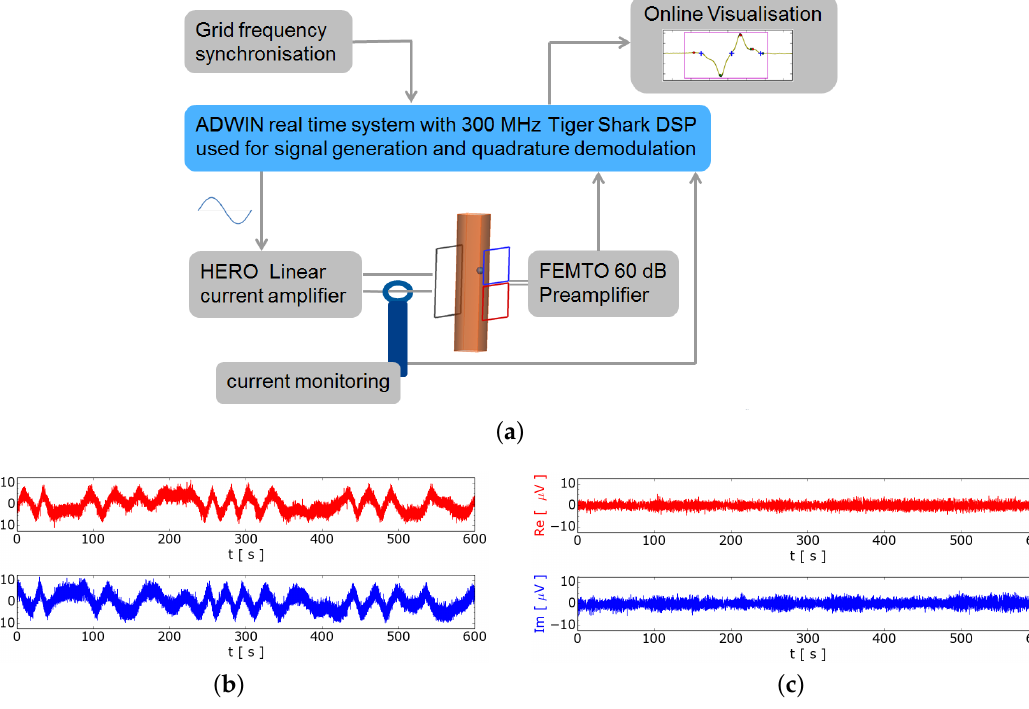
Figure 3. Measurement setup with synchronization to the grid ( a ) Signal generation and instrumentation; ( b ) Free running excitation; ( c ) Excitation synchronized to the